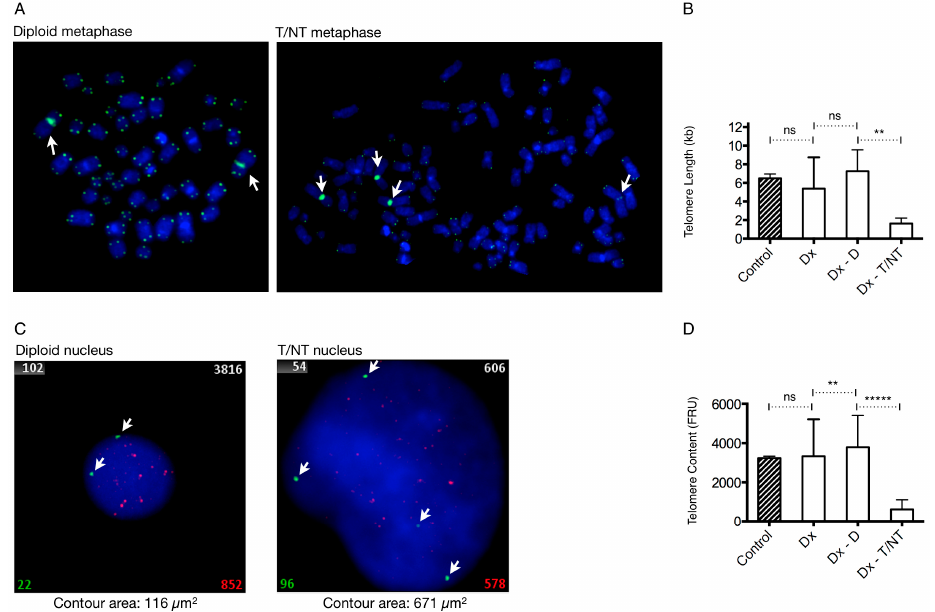
Figure 2. Telomere quantification with telomere/centromere fluorescence in situ hybridization (T/C FISH). ( A ) Representative metaphases from a diploid metaphase (left-hand panel) and a near-tetraploid metaphase (right-hand panel). Telomere signals have a lower intensity in the near-tetraploid metaphase than in the diploid metaphase or are even missing in some chromosome arms. ( B ) Mean telomere lengths (kilobases) in a normal healthy age-matched control and in Case 2 at diagnosis, where telomere measurements are from un-sorted metaphases at (Dx) or after ploidy scoring into diploid metaphases (Dx-D) and near-tetraploid metaphases (Dx-T/NT). Near-tetraploid metaphases show significantly shorter telomeres compared with diploid metaphases ( p = 0.0013), whereas there were no significant differences between the other groups. ( C ) Representative nuclei with diploid chromosomal complement (left-hand panel) and T/NT chromosomal complement (right-hand panel) are shown together with their respective contour area in µ m 2 . The fluorescence intensity of chromosome 2 centromeric and pan-telomeric probes is displayed in the left and right bottom corners, respectively. The ratio between telomeric and centromeric 2 fluorescence intensities multiplied by 100 is displayed in the upper right corner. Cell number is displayed in the upper left corner. ( D ) Mean telomere content defined as FRU (fluorescence ratio units) determined in the same healthy age-matched control as before and in Case 2 at diagnosis, where telomere measurements are from un-sorted nuclei (Dx) or after ploidy scoring into diploid nuclei (Dx-D) and near-tetraploid nuclei (Dx-T/NT). Near-tetraploid nuclei have significantly lower telomere content compared with diploid cells ( p < 0.0001). There was no significant difference between un-sorted nuclei and nuclei from the control. White arrows indicate centromere 2 signals. After significance testing number of asterisk indicate significance level: ****: extremely significant ( p < 0.0001); ***: extremely significant (0.0001 < p > 0.001); **: very significant (0.001 < p > 0.01); *: significant (0.01 < p > 0.05); and ns: not significant ( p ≥ 0.05). Dx is unsorted cells at diagnosis, Dx-D is scored diploid cells at diagnosis, and Dx-T/NT is tetraploid/near-tetraploid scored cells at